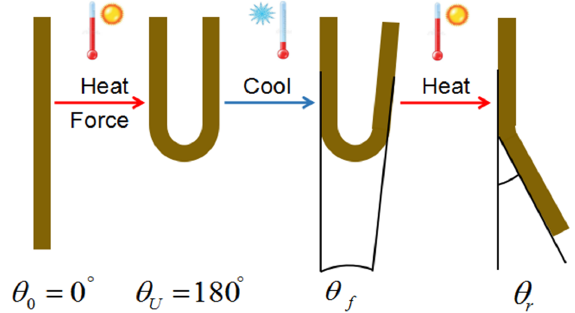
Figure 1. Schematic diagram of the quantitative analysis of shape memory behavior in a bending test.